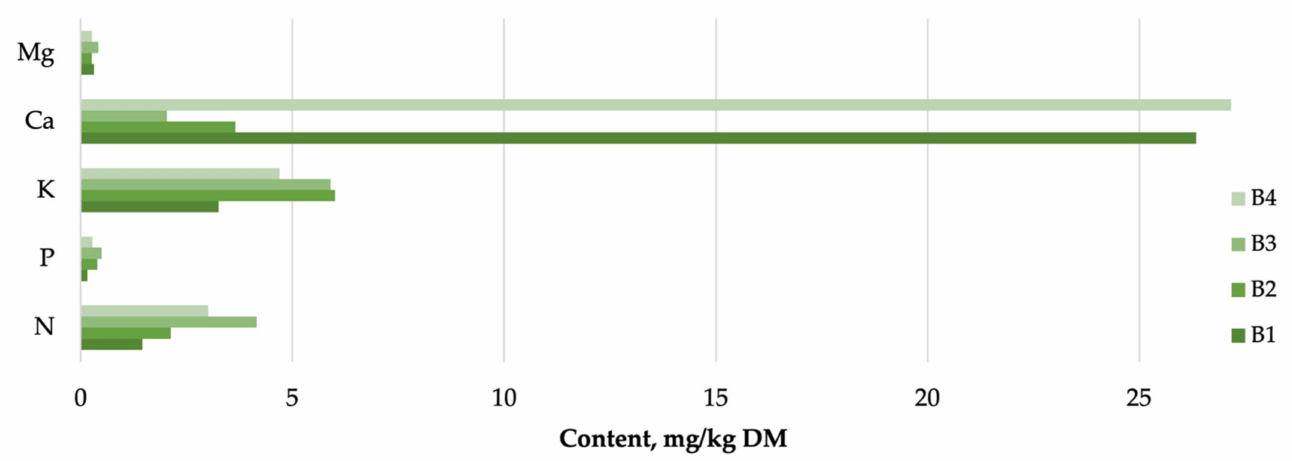
Figure 2. Separate macro elements content in C. glomerata biomass from different rivers in Lithuania (Dubysa (B1); Šventoji (B2); Nev˙ežis (B3); J¯ura (B4)).